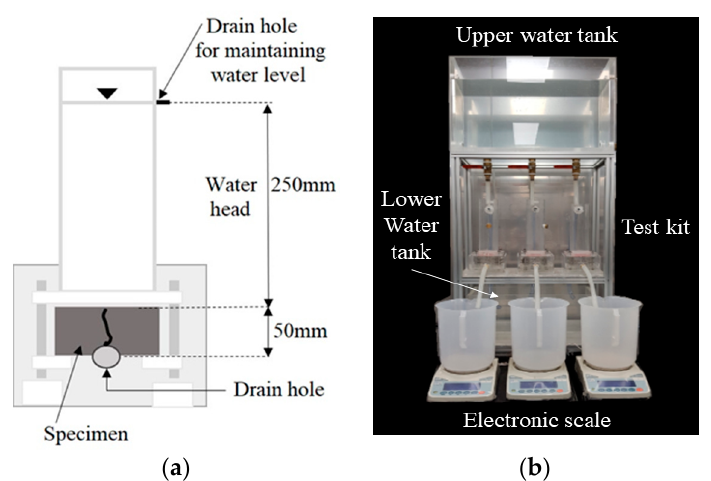
Figure 4. Water permeability test apparatus: ( a ) schematic diagram, ( b ) photograph. The amount of water coming out of the test equipment was measured for 7 min after the water head and water flow stabilized. To normalize the results for specimens with various crack shapes, the test duration and crack length were considered. The water flow rate in units of mL/(mm ⋅ min) was obtained by dividing this amount of discharged water by the test duration (min) and crack length (mm). The cracked specimens were cured separately in water at 20 °C and grouped by the mixture type to prevent possible ion-exchange that could occur during the healing period. The amount of water was also controlled to be 500 mL for each specimen. This was achieved by adding the evaporated amount of water back into the containers once per week after the water permeability testing. With this process the possible effect of curing water was minimized. The water permeability test was conducted for healing periods of 0, 7, 14, 21, and 28 days. The specimens were stored in the same container between subsequent measure- ments. Because there was the possibility of disturbing the self-healed products of the spec- imens, preconditioning, such as vacuum saturation, was not performed before the perme- ability test. 4. Experimental Results and Discussion 4.1. Fundamental Properties Fundamental properties such as the compressive strength and the slump flow were measured. The compressive strengths of the mortars were measured according to KS L ISO 679 “Methods of testing cements-Determination of strength.” Table 2 shows the strength measured at 7 and 28 days after curing. The 28-day strengths of self-healing mix- tures (SH1, SH2, SH3) were 106.6%, 92.3%, and 108.1% of that of the Plain mixture. Table 2. Slump flow and compressive strength test results for mortar mixtures. Types